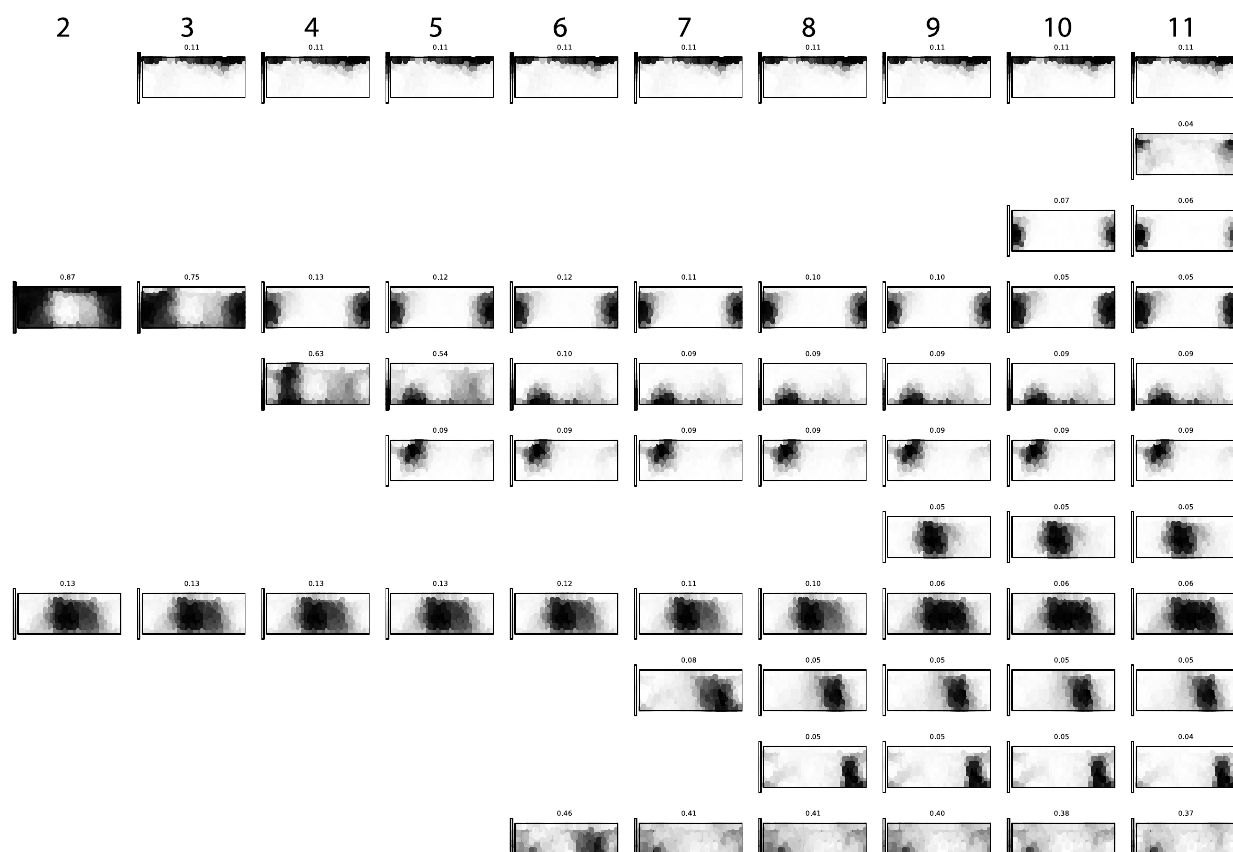
Figure 5. k -means clustering hierarchy on all response vectors, after projecting by a factor of the exponential similarity matrix for color